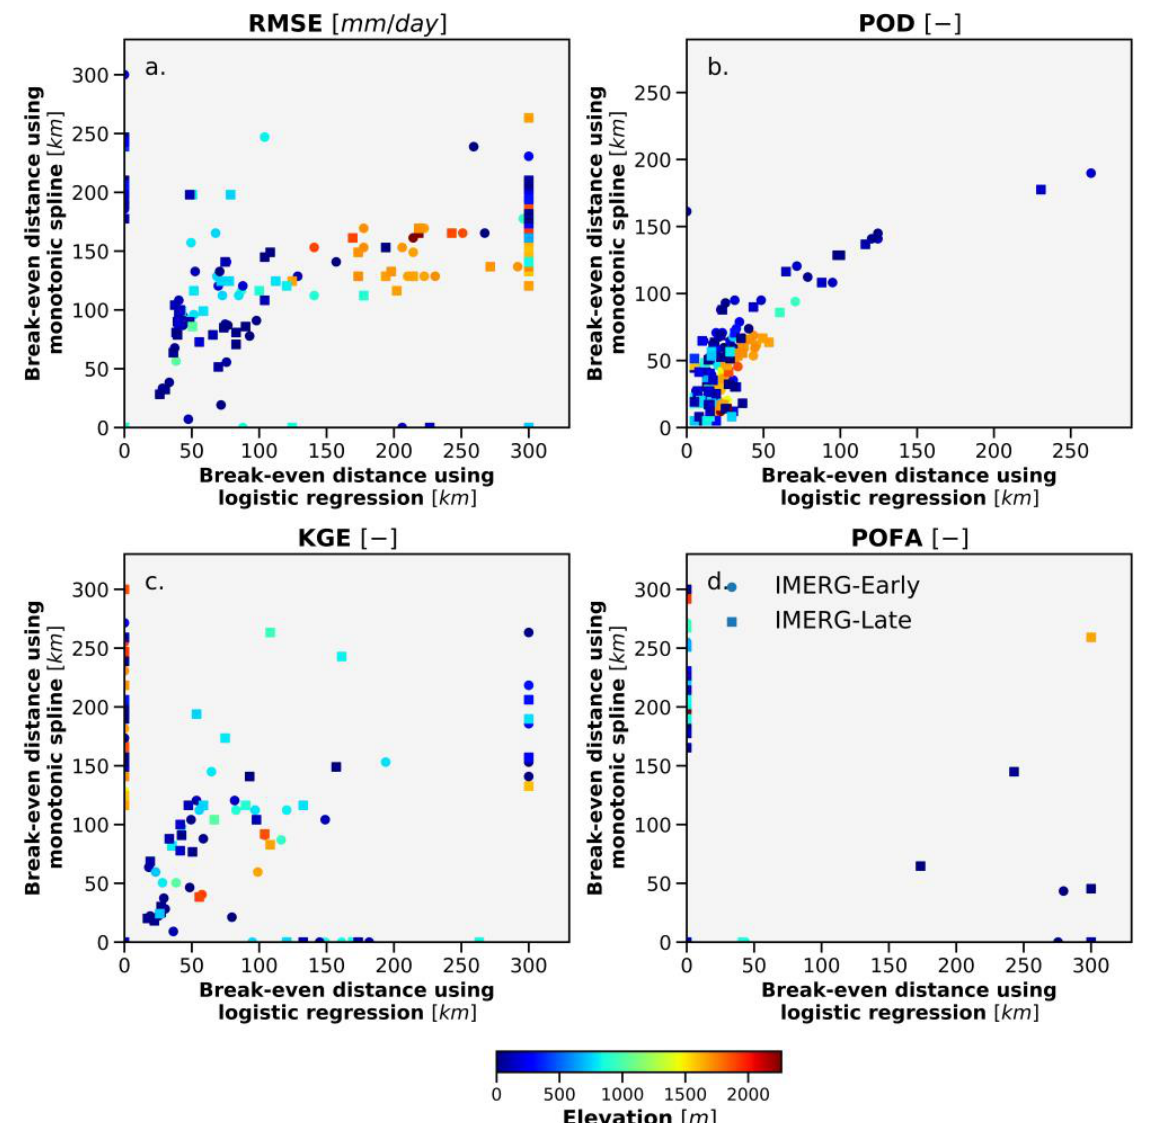
Figure 6. Break points for the distance to nearest gauge at which IMERG-Early and Late can be expected to perform similarly to interpolated gauge data in terms of ( a ) RMSE, ( b ) POD, ( c ) KGE, and ( d ) POFA. Note that the highest distance to nearest gauge assessed was 200 km and that the high number of pixels estimated to have a RMSE break point at 200 km is reflective of the logistic regression’s tendency to “flatten out” at high distances beyond those used during regression fitting. Table 1. The average and ± standard deviation of break-even points in CONUS and Brazil study areas in terms of both gauge density and distance to nearest available gauge. IMERG-Early break- points are shown out of parentheses and IMERG-Late breakpoints are in parentheses.